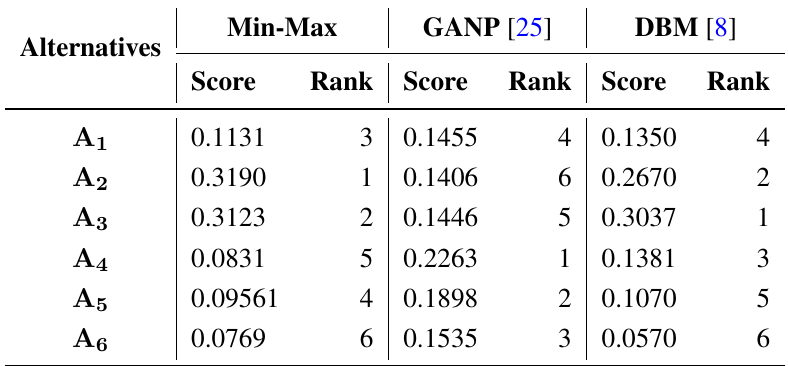
Table 12. Final optimal